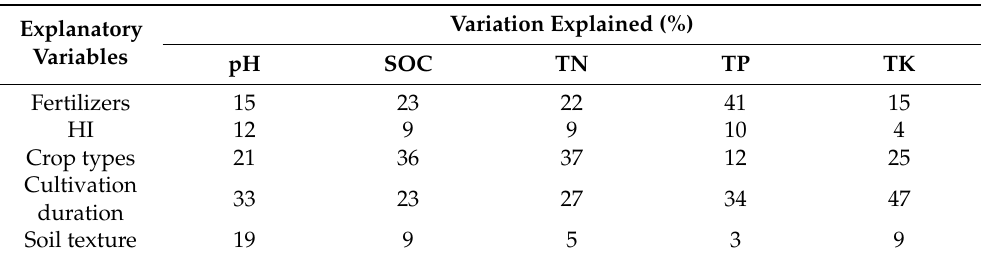
Table 2. Significance of the explanatory variables for the responses of soil chemical properties (pH, SOC, TN, TP and TK) according to BRT (boosted regression tree)